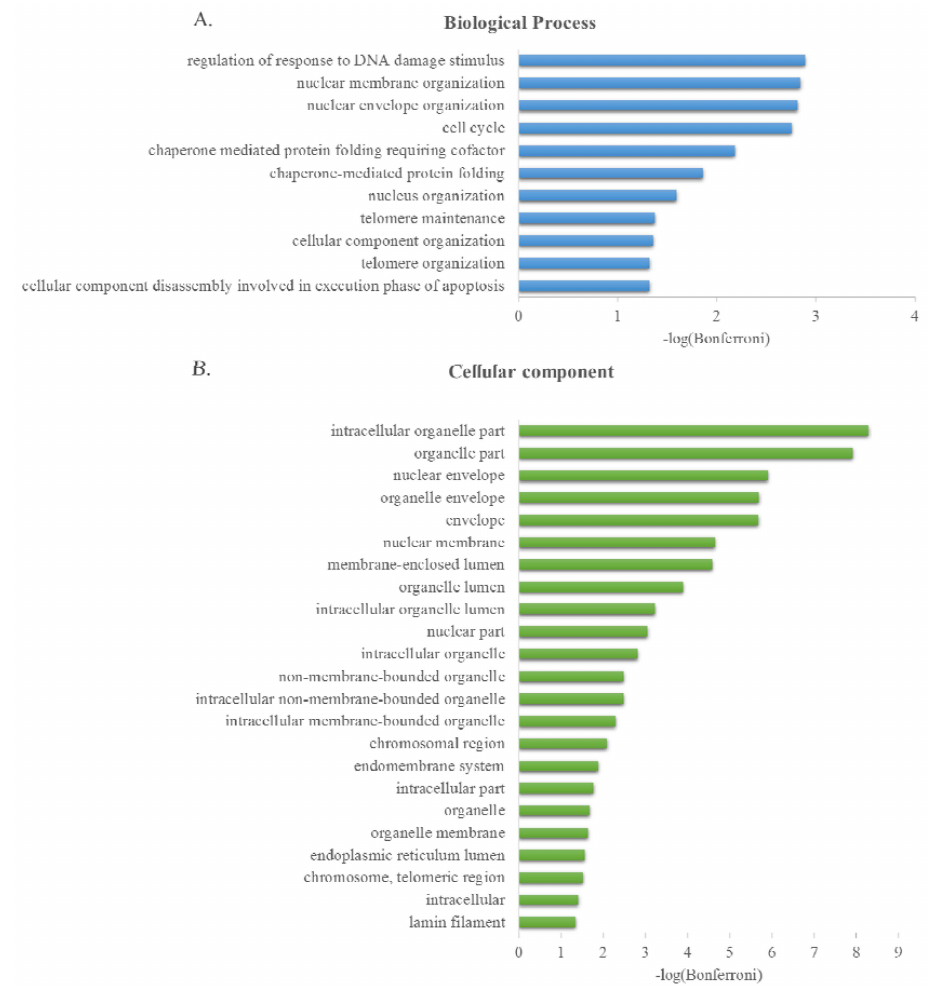
Figure 4. Significantly enriched Gene Ontology terms from LAP1 interaction network ( A ) Biological process; and ( B ) Cellular Component. Bonferroni corrected p -values ( α = 0.05) were transformed by ´